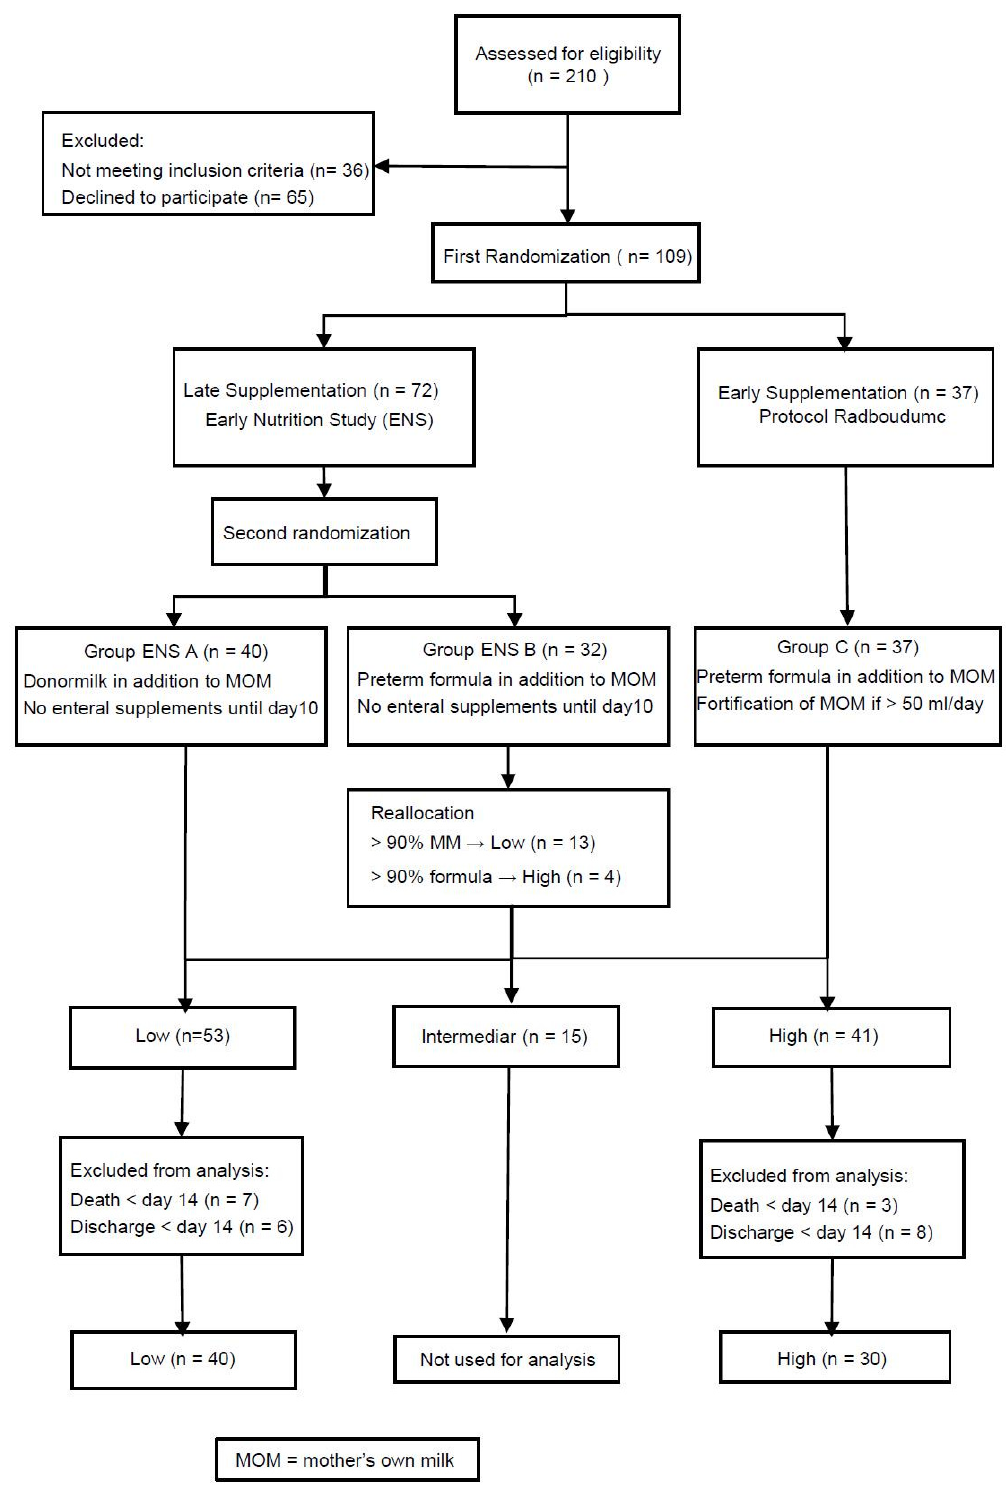
Figure 1. Consort Figure 1. Consort diagram.